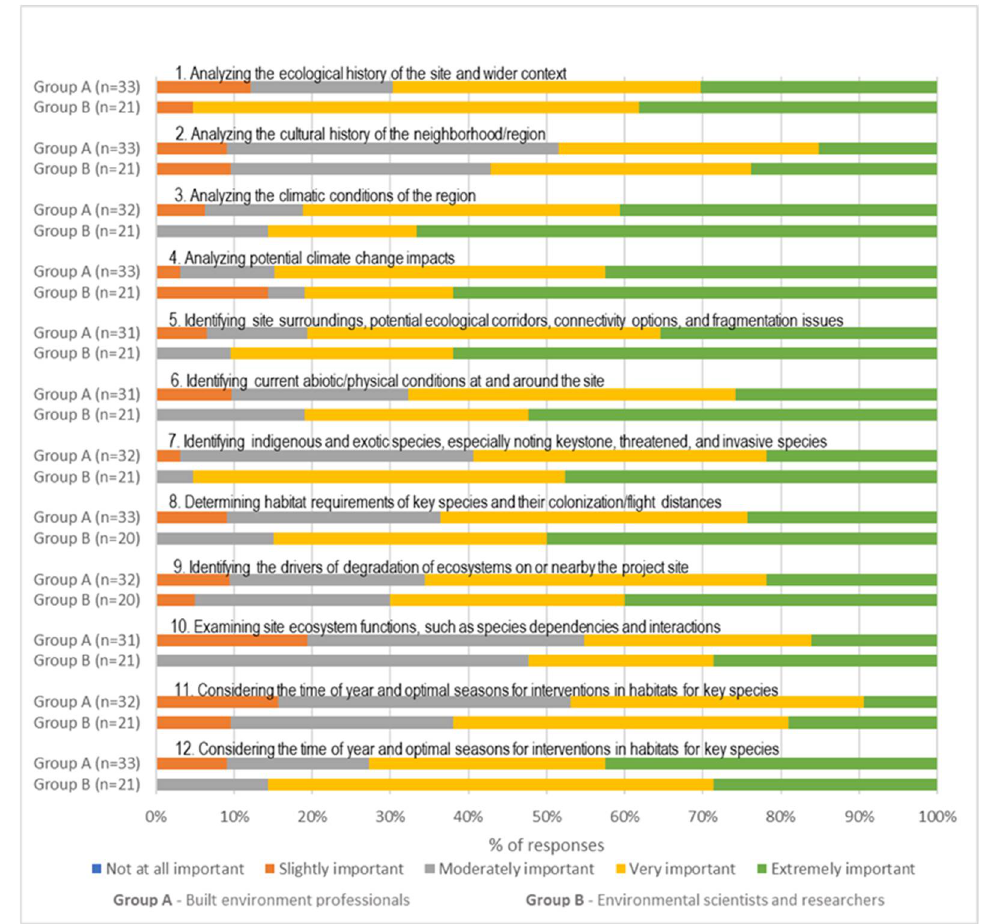
Figure 11. Research or data gathering approaches for habitat provisioning.